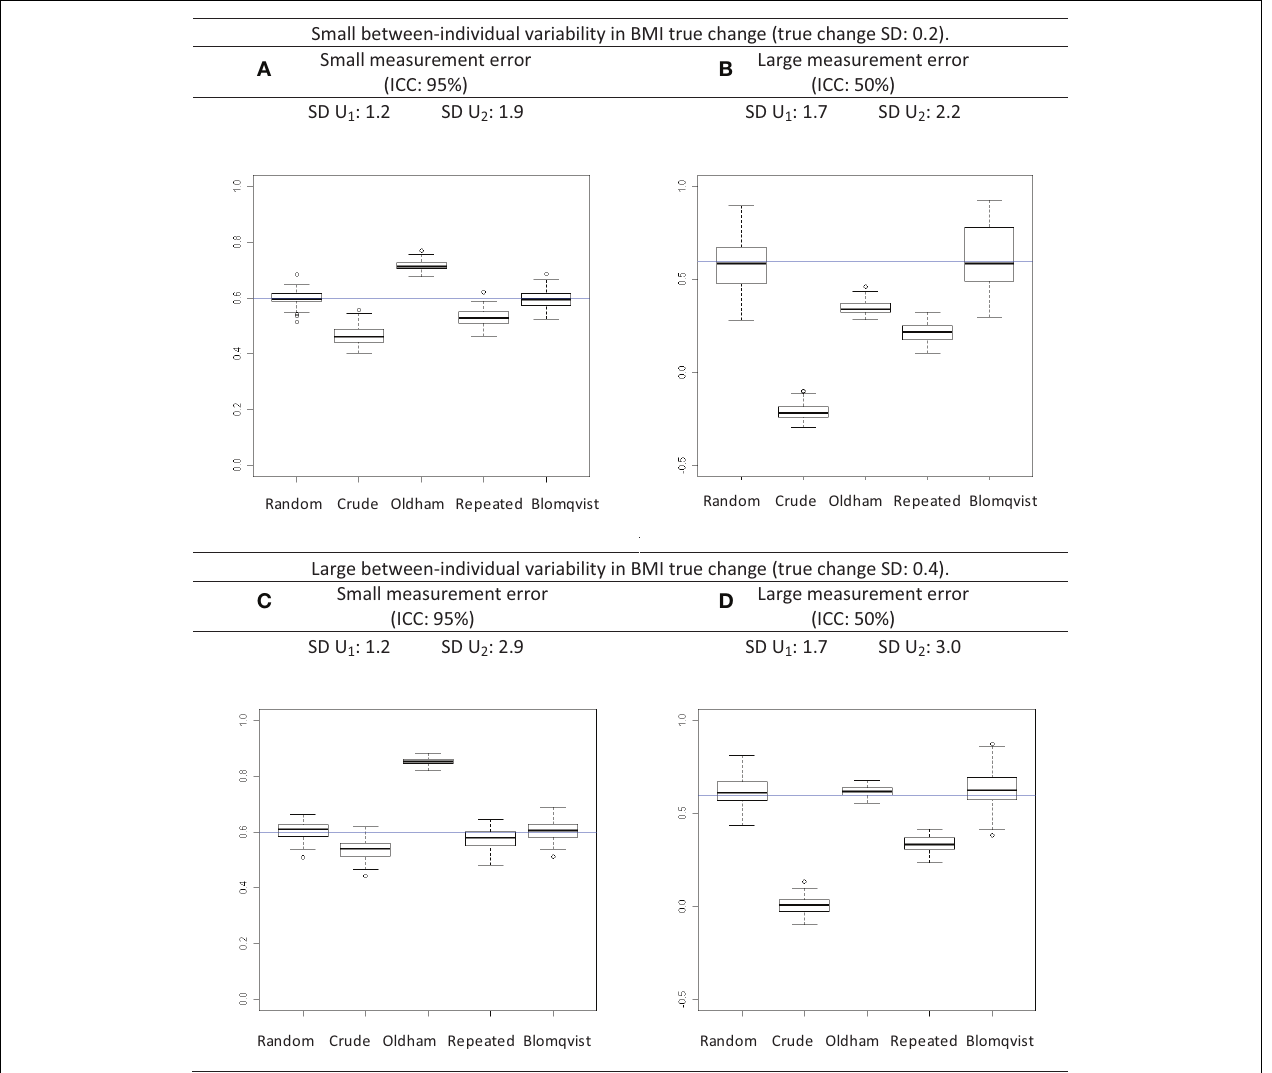
Oldham’s method; Repeated: estimates using repeated measurement method; Blomqvist: estimates using Blomqvist’s method. (A) Results in case of small between-individual variability in BMI true change and of small measurement error. (B) Results in case of small between-individual variability in BMI true change and of large measurement error. (C) Results in case of large between-individual variability in BMI true change and of small measurement error. (D) Results in case of large between-individual variability in BMI true change and of large measurement